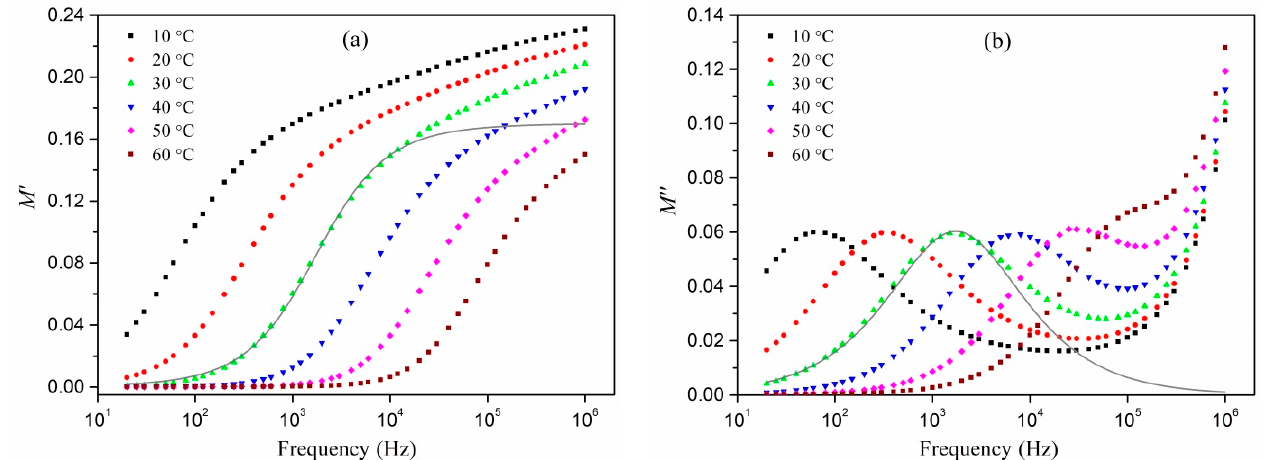
Figure 3. Electrical modulus vs. AC frequency: real ( a ) and imaginary ( b ) elements in Ag/PAN nanocomposite made from